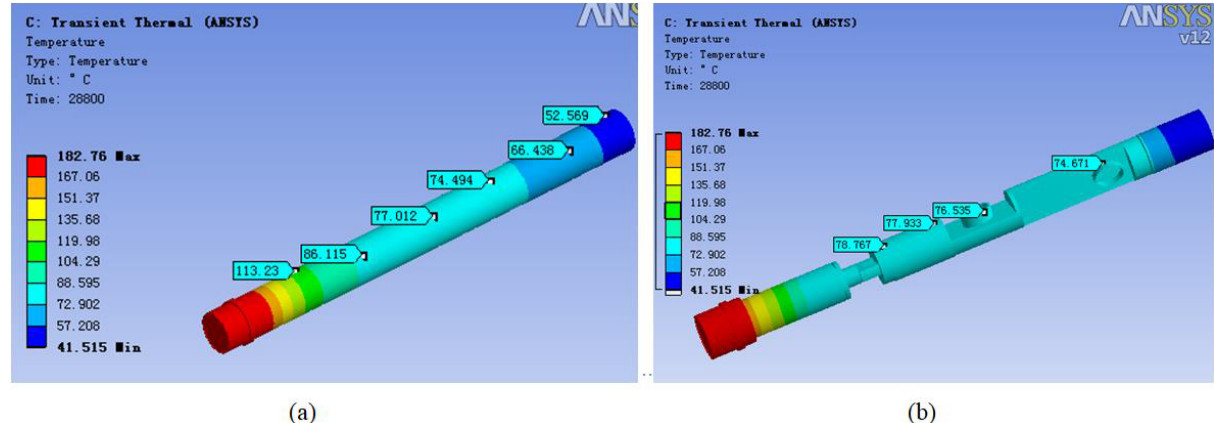
Figure 19. (a) Temperature distribution nephogram of the metal vacuum flask after 4h of work; (b) temperature distribution nephogram of the FOG measurement probe after 4h of